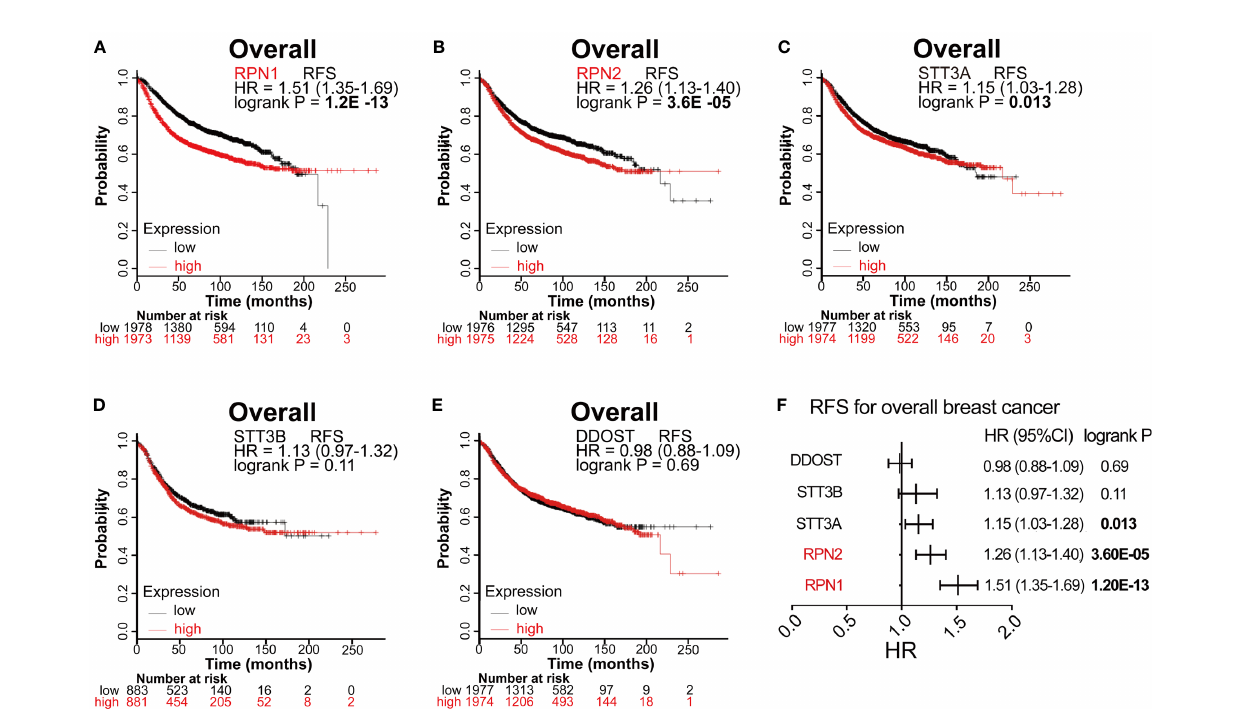
FIGURE 4 | Survival analyses of the fi ve subunits in BC (RFS in Kaplan – Meier Plotter). (A – E) RFS for RPN1, RPN2, STT3A, STT3B, and DDOST in all BC. P<0.05 was considered statistically signi fi cant. (F) Prognostic HR of RFS for the fi ve subunits. The data with statistical signi fi cance (P<0.05) were marked in bold text. RFS, relapse-free survival; HR, hazard ratio; CI, con fi dence